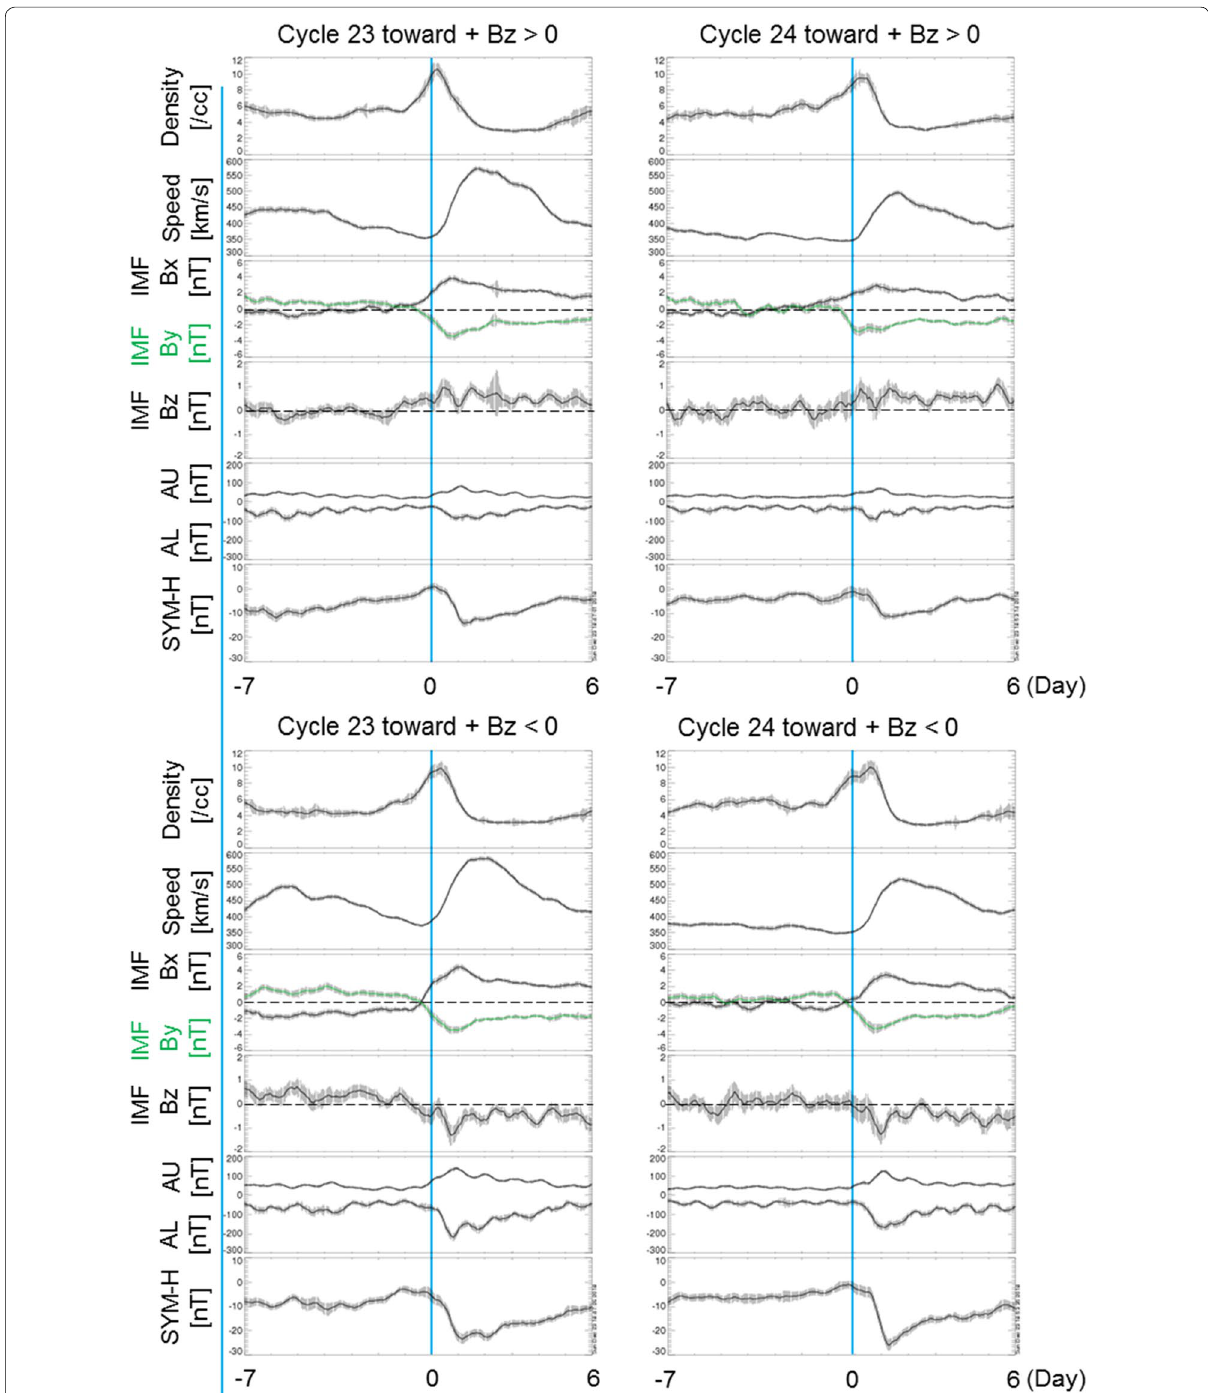
Fig. 10 Half-day averaged variation of solar wind proton density, solar flow velocity, and IMF, geomagnetic indices in the case of “toward” (IMF Bx > 0 and By < 0) during solar cycle 23 and 24. The vertical light blue line represents the start time of an enhancement of solar wind velocity around the Earth’s orbit. The error bar represents the standard